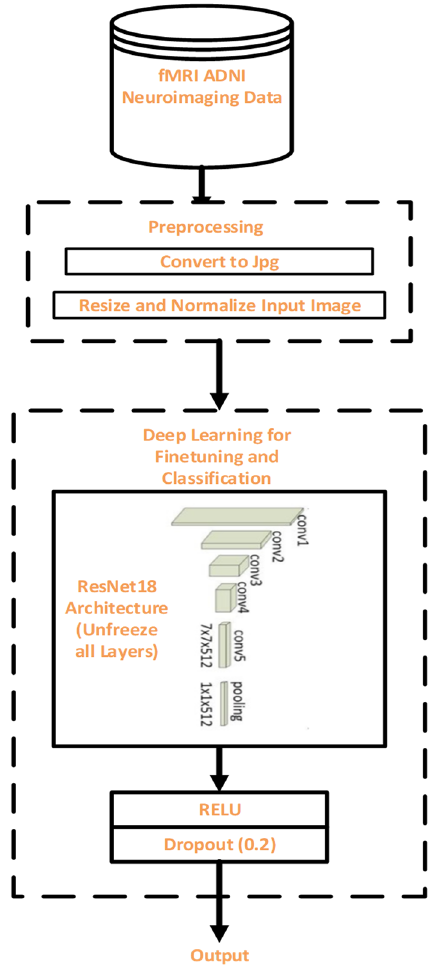
Figure 1. Flow diagram for the proposed